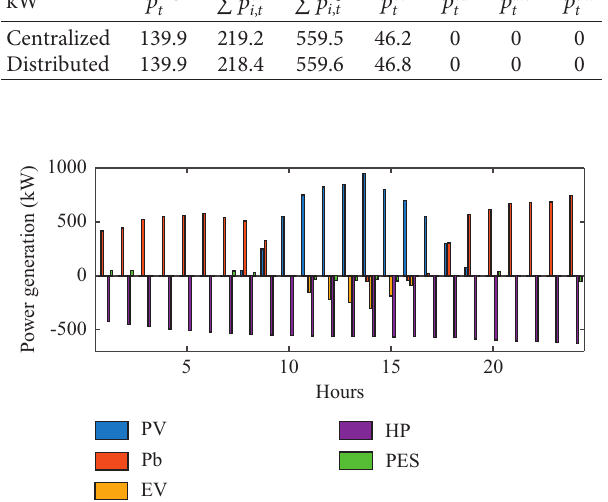
Figure 5: Day-ahead scheduling in the DC grid.